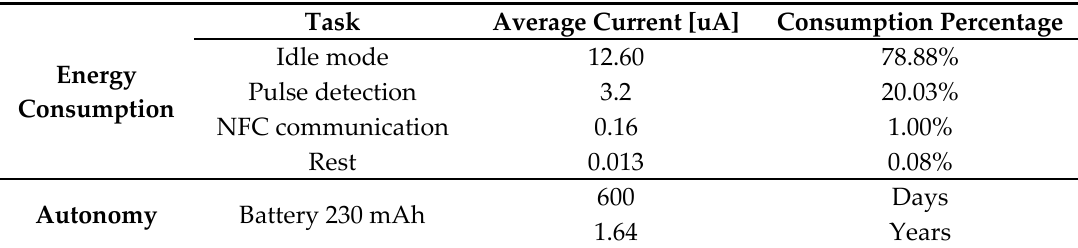
Table 2. Average current consumption detailed by each task performed. A 3V coin cell battery powers the node. It is assumed that an NFC communication will take place every five days and one pulse detection will happen every 30